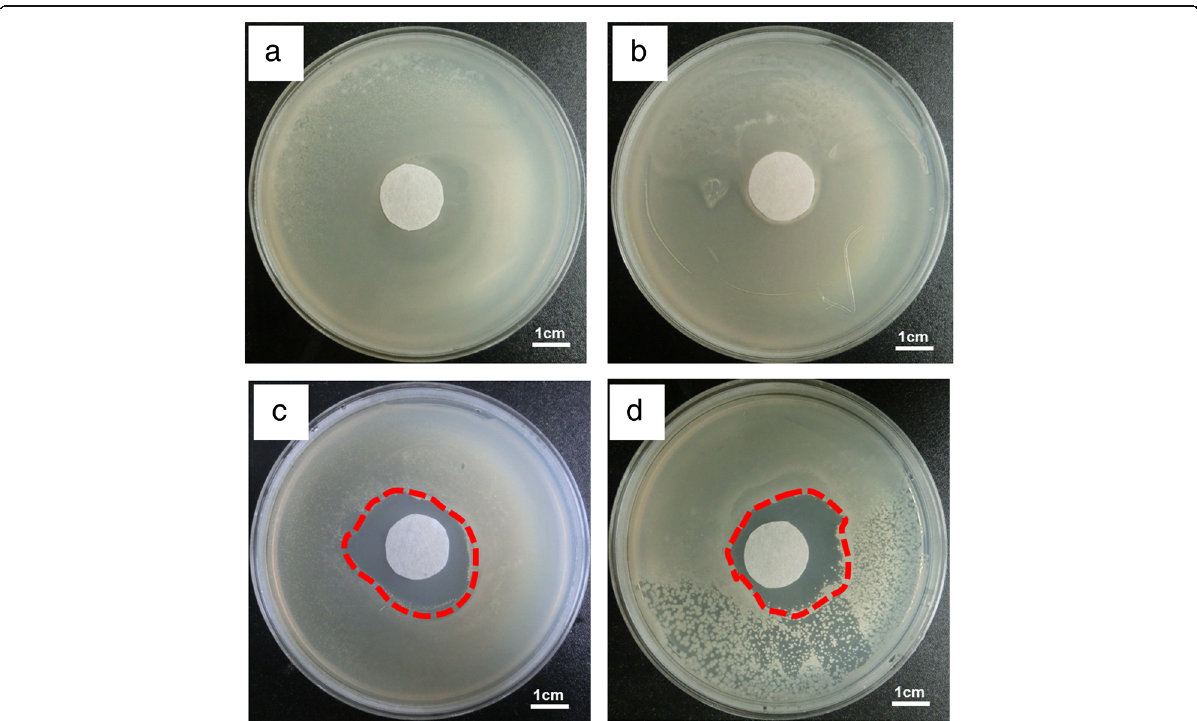
Fig. 6 The inhibition of CMCS/PEO nanofibers on Staphylococcus aureus and Escherichia coli . a Staphylococcus aureus with filter paper (control), b Escherichia coli with filter paper (control), c Staphylococcus aureus with CMCS/PEO nanofibers, and d Escherichia coli with CMCS/PEO